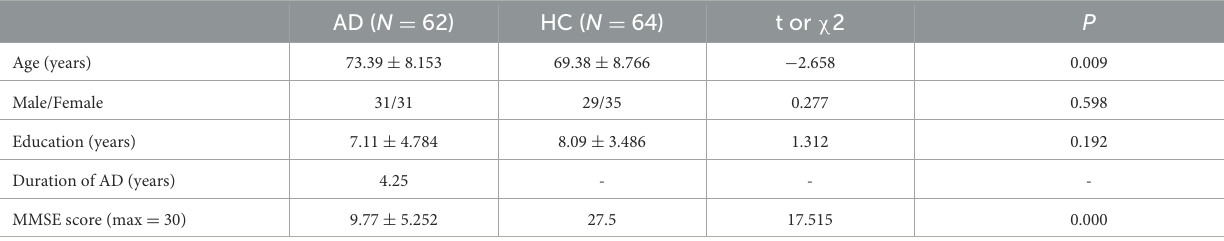
TABLE 1 Participant demographic and clinical features.